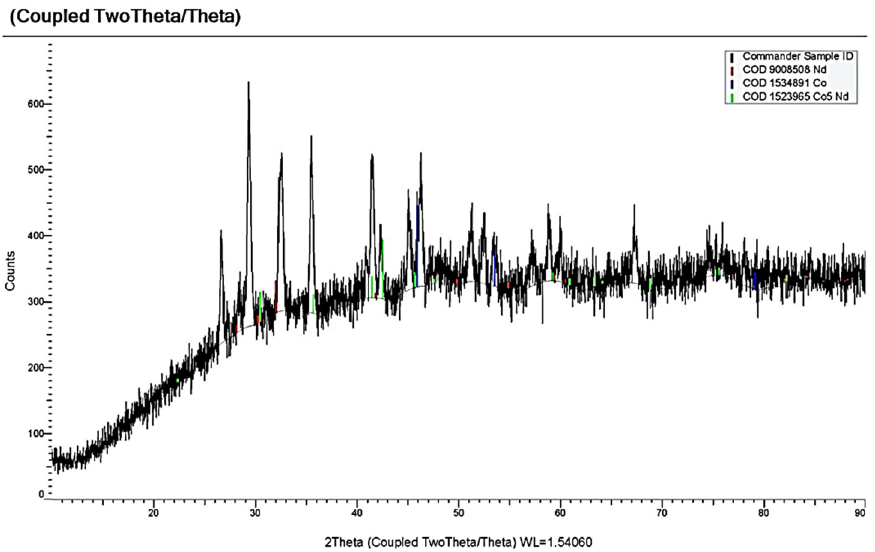
Figure 12. X-ray pattern of the cathode deposit obtained by electrolysis of the KCl-NaCl-NdCl 3 -CoCl 2 melt at 973 K for 1 h and the cell voltage of 3.4 V. Concentration of NdCl 3 is 3.0 × 10 − 4 mol/cm 3 . Concentration of CoCl 2 is 0.5 × 10 − 4 mol/cm 3 .